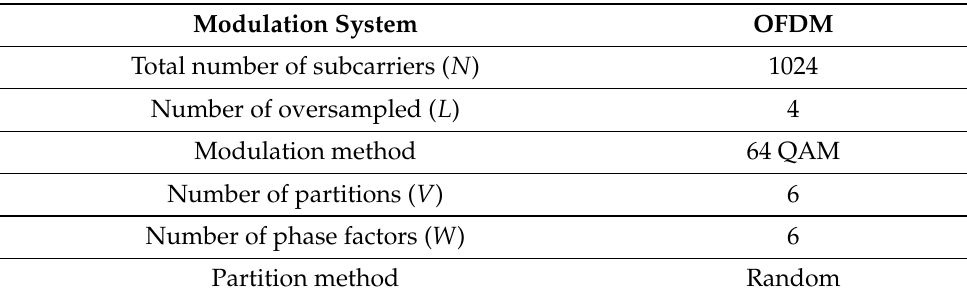
Table 3. Simulations